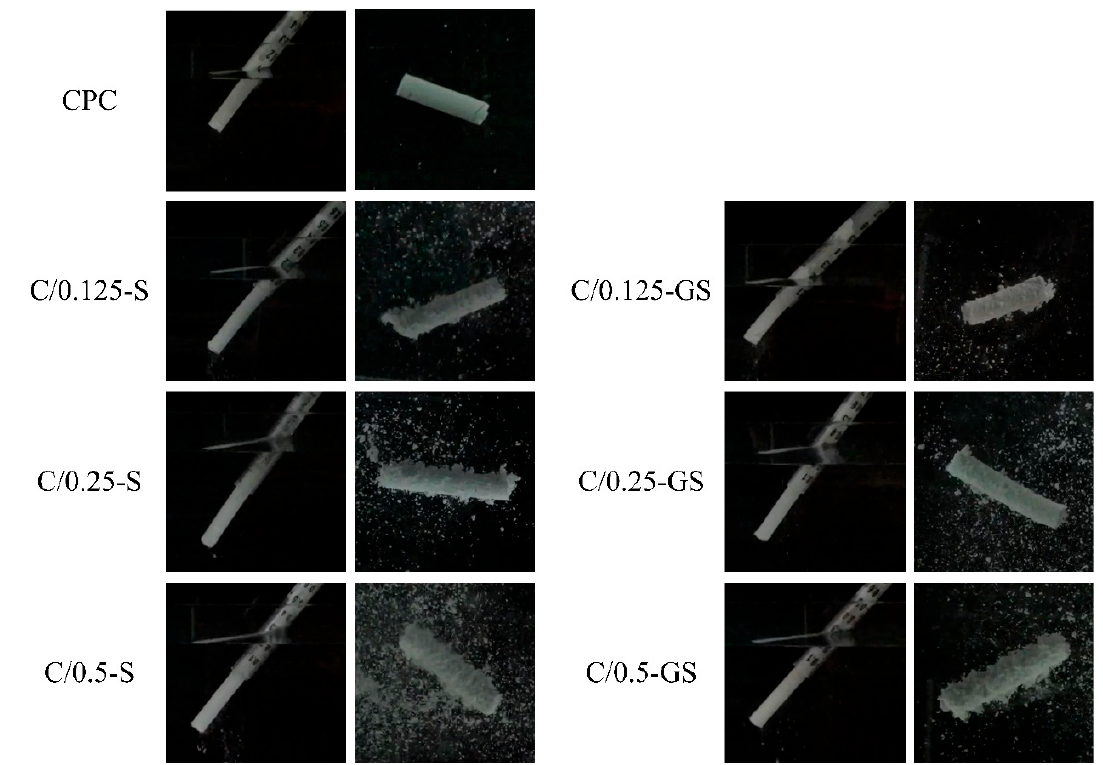
Figure 5. Injectability ( left images ) and anti-disintegration ( right images ) of different CPC/hydrogel composites in ddH 2 O.